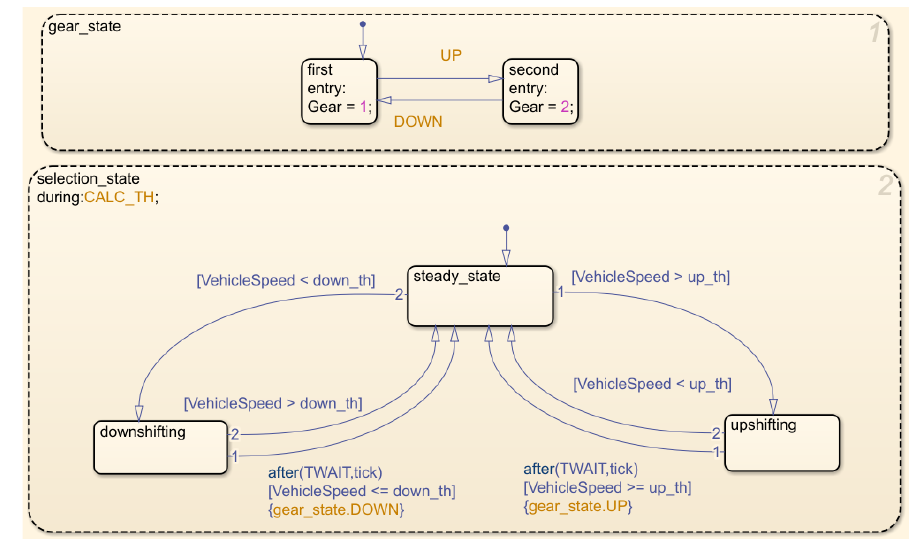
Figure 16. The shift logic model.